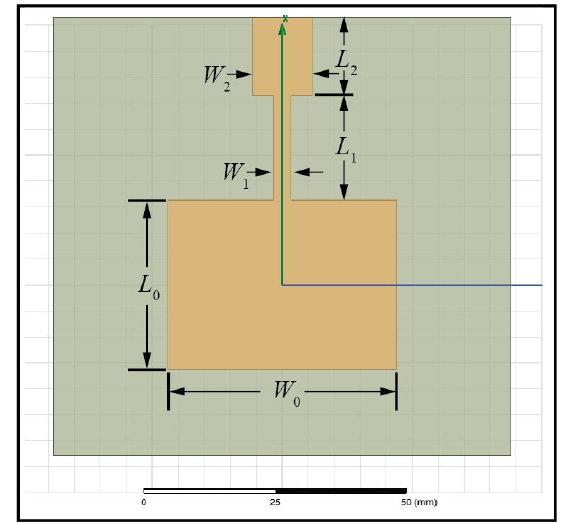
Figure 13. Patch antenna layout on ANSYS Electronics Desktop.